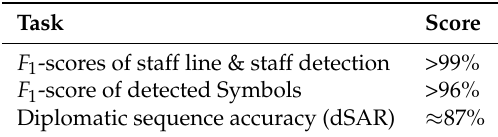
Table 11. Overview of the main results of this